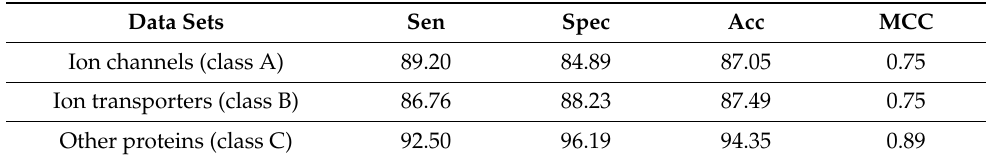
Table 10. Comparison of the performance on the classification of the ion transporters and the ion channels from a set of the membrane proteins utilizing 5-fold techniques of the cross validation. Due to copyright issues, the table is reconstructed using data from ref.